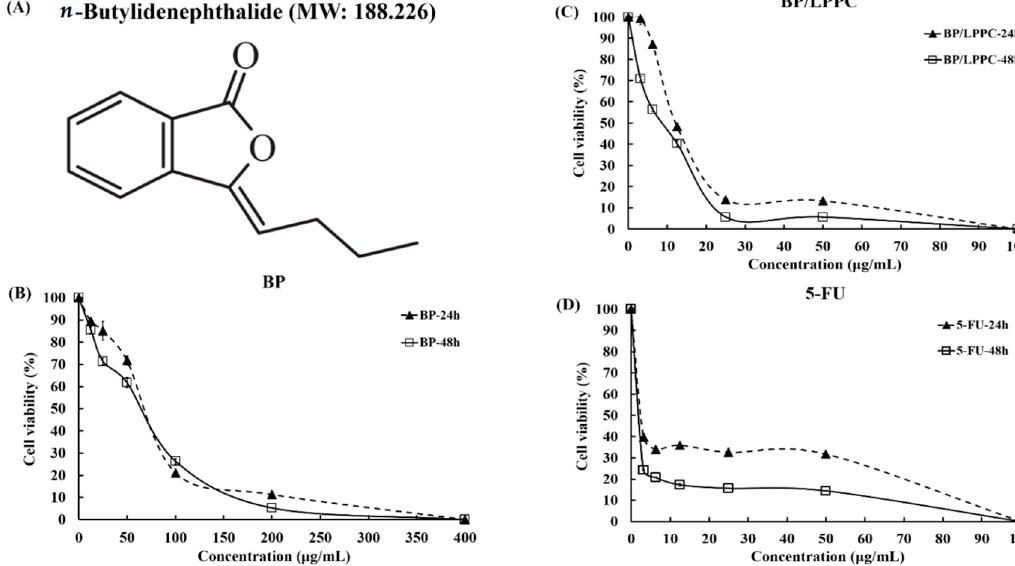
Figure 1. The inhibition curve of n -Butylidenephthalide (BP)/polyethylene glycol complex (LPPC) on B16/F10 melanoma cells. ( A ) The chemical structure and molecular weight of n -Butylidenephthalide (BP). B16/F10 cells were plated in 96-well culture plates and treated with ( B ) BP (0–400 µg/mL), ( C ) BP/LPPC (0–100 µg/mL), and ( D ) 5-Fluorouracil (5-FU) (0–100 µg/mL) with serial dilution for 24 and 48 h. The cell viability was measured using MTT assay, and calculated by the following: cell viability (%) = (O.D. value of treatment group/O.D. value of control group) × 100%. The results showed mean ± SD. Table 1. The cytotoxicity (IC 50 ) of BP/LPPC in tumor and normal cells. Cell Line